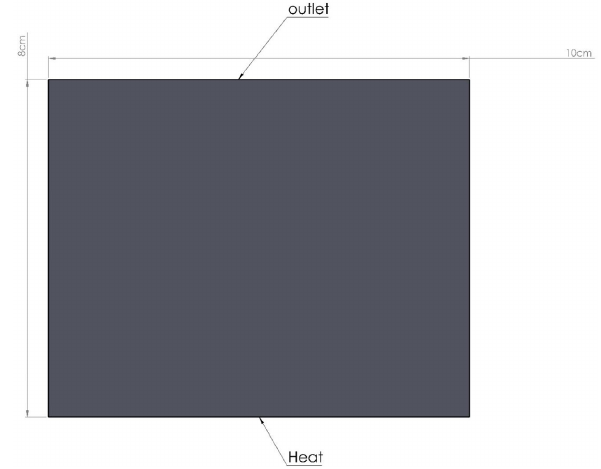
Figure 1: Geometry